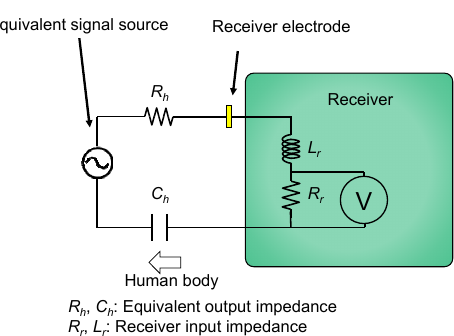
Figure 8. Equivalent circuit of impedance matching.